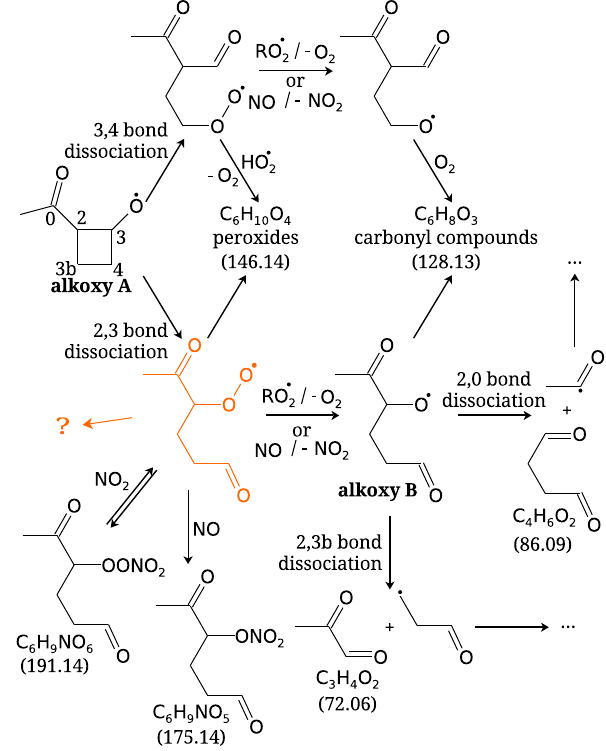
Fig. 4. Ring opening chemical mechanism of the alkoxy radical A from Fig. 2. Carbon-carbon bond 2–3 or 3–4 can dissociate, lead- ing to the formation of different compounds. The formed “alkoxy B” can also undergo carbon-carbon bond dissociation. The num- bers in brackets correspond to the molar mass of the compounds. See text for more